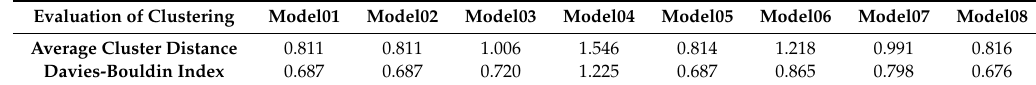
Table 1. Clustering measurements.